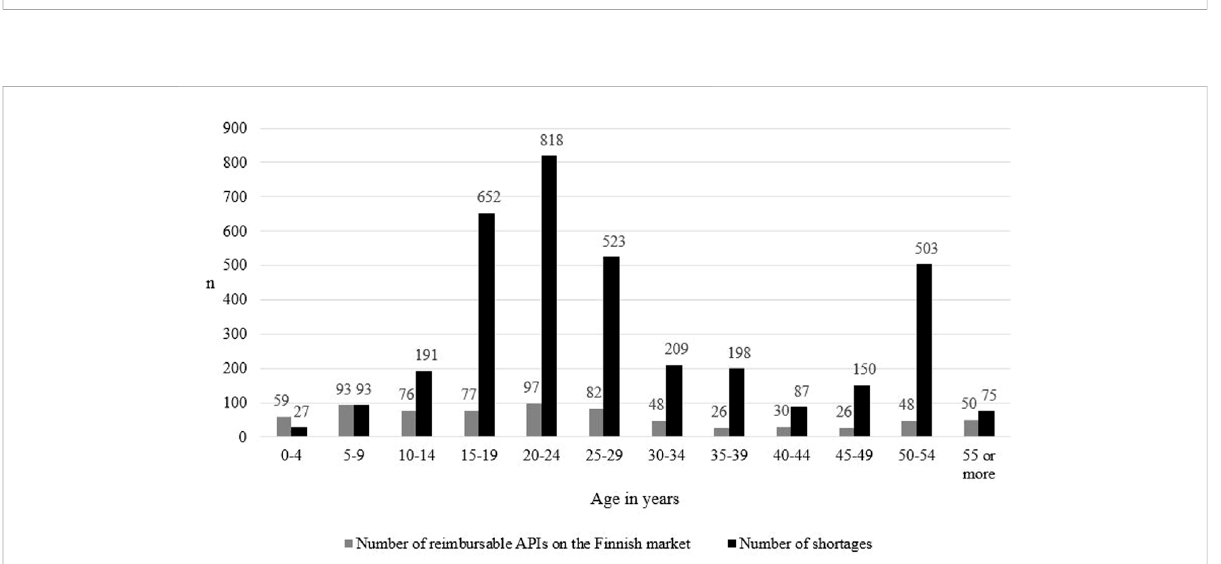
FIGURE 2 The number of reimbursable active pharmaceutical ingredients (API) marketed in Finland ( N = 712, based on Kari et at, unpublished), and the numberofmedicineshortagesinFinlandfrom2017to2019( N =3,526)andtheageoftheproductscalculatedfromthe fi